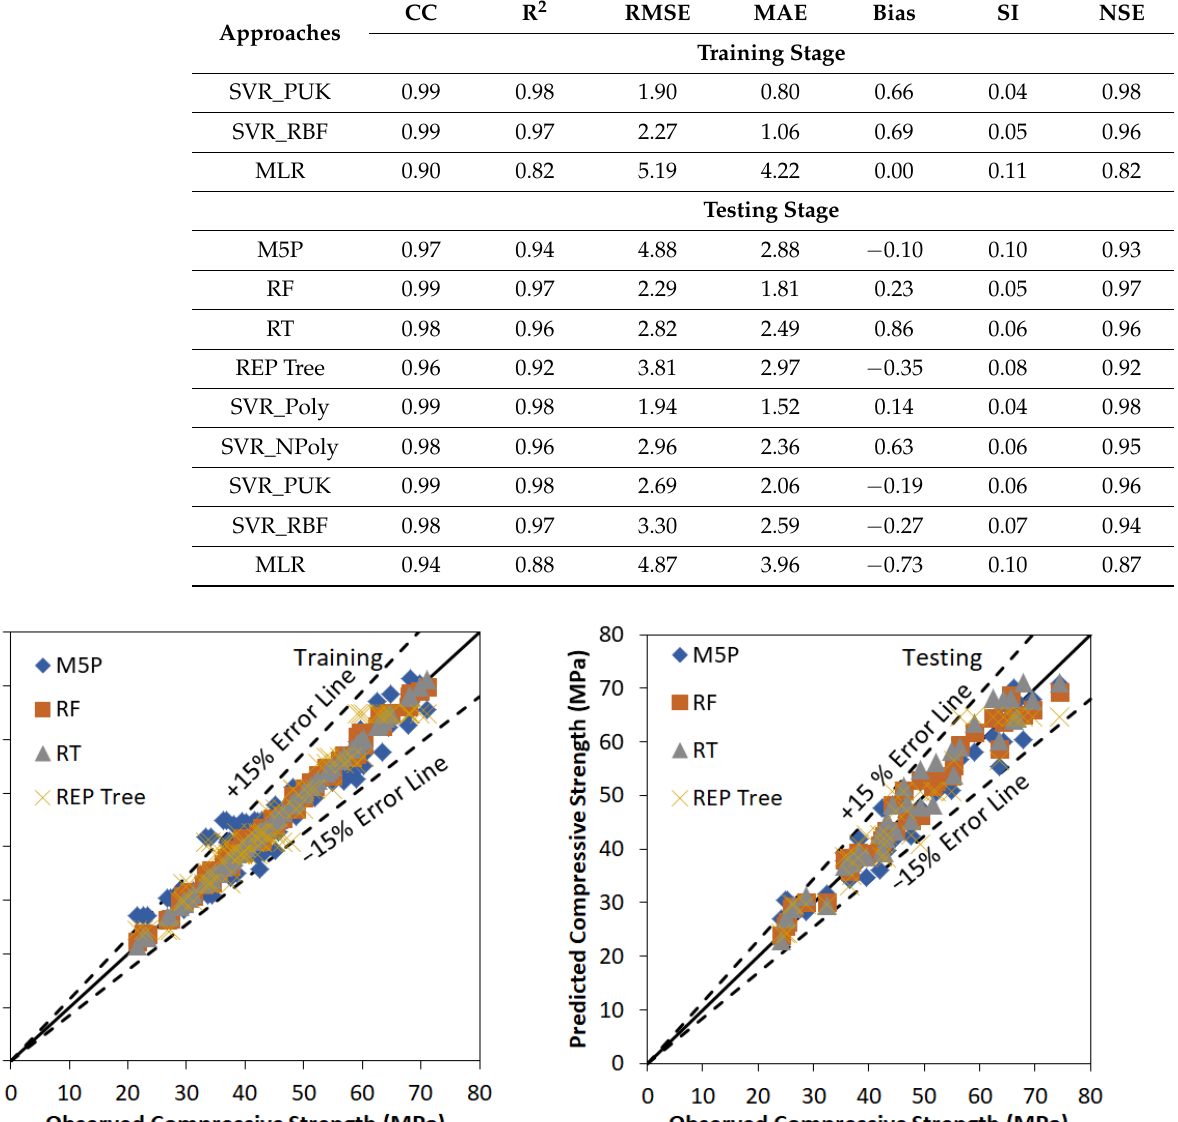
Figure 3 SVR_Poly denotes the Polynomial kernel function based support vector Regres- sion based model, SVR_NPoly denotes the Normalized Poly kernel function based sup- port vector Regression based model, SVR_PUK denotes the Pearson VII kernel function based support vector Regression based model and SVR_RBF denotes the Radial basis kernel function based support vector Regression based model. 5.4. Comparison among Regression and Soft Computing-Based Models In this investigation predictive accuracy of M5P, RF, RT, REP, and SVR based mod- els have been assessed for the prediction of the compressive strength of bacterial con- crete. The results have been compared with the multiple linear regression-based model (Table 6). For this purpose, seven statistical performance indices are selected namely CC, R 2 , RMSE, MAE, Bias, SI, and NSE. The results of performance evaluation indices rec- ommend that polynomial kernel function-based support vector regression-based model performed better than other soft computing and regression-based models with CC (0.9919, 0.9901), R 2 (0.9839, 0.9803), NSE (0.9832, 0.9800), RMSE (1.5680, 1.9384), MAE (0.7854, 1.5155), Bias (0.2353, 0.1350) and SI (0.0347, 0.0414) for training and testing stages, respectively. Overall SVR based models work better than a tree and MLR-based models except for SVR_NPoly based model. In tree-based models, RF based model is performing better than other tree based applied models. Overall MLR-based model performance is the least among all applied models with CC (0.9373), R 2 (0.8786), RMSE (4.8727), MAE